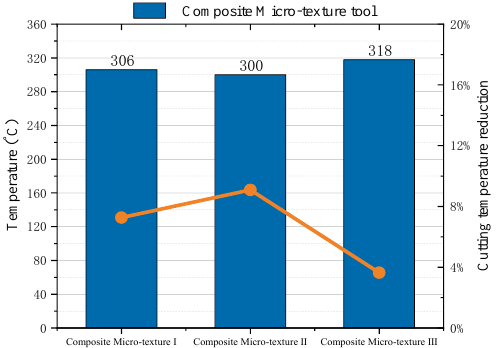
Figure 9. Cutting temperature of three kinds of composite micro−texture tools.